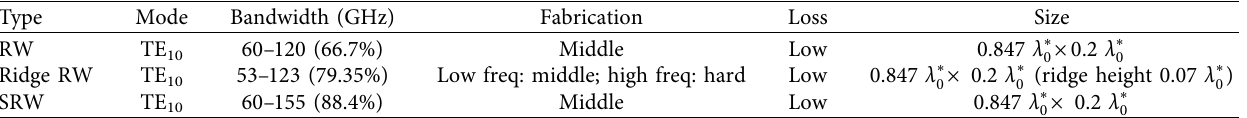
Figure 7: The dominant (TE10 mode) and high-order mode (TE20 mode) transmission coefficients of RW, SRW, and Ridge RW. Table 2: Comparing the transmission characteristics of transmission lines.